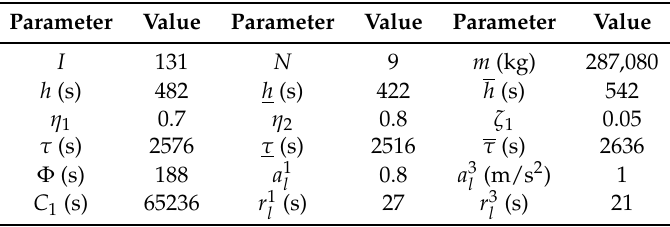
Table 2. Other Parameters of Yanfang Line.